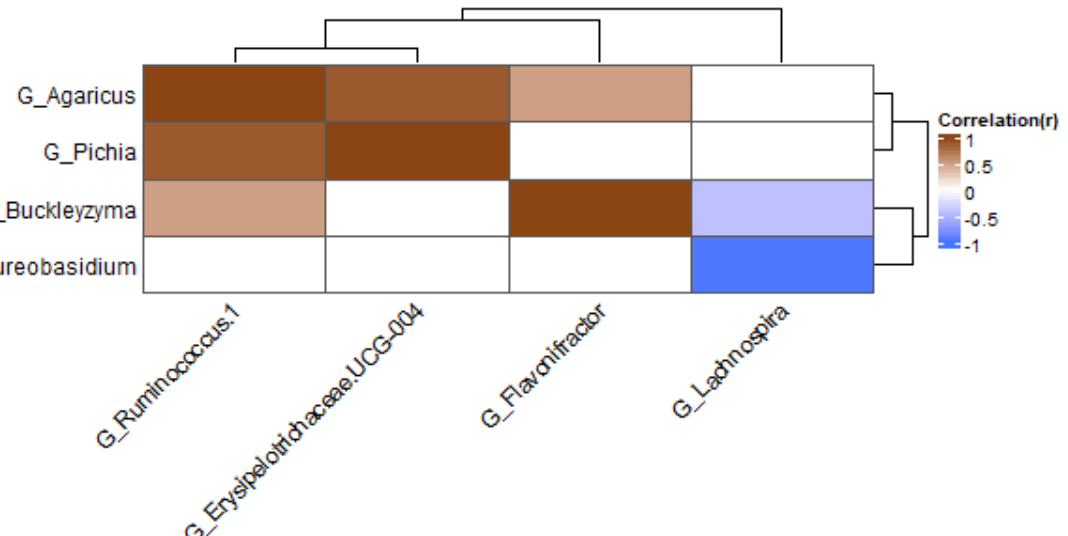
Figure 9. Heatmap at genus level for antibiotics samples; only genera present in at least 20% of samples were included.